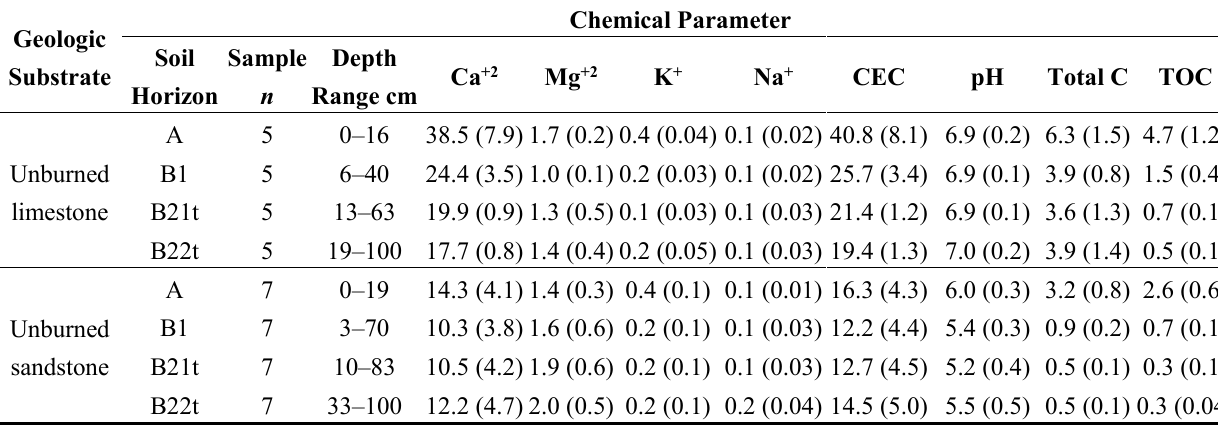
Table 9. Physical and chemical characterization of unburned limestone ( n = 5 sites) and sandstone ( n = 7 sites) soils on the Dude Wildfire study area 10 years postfire. Depths ranges are in centimeters for the sample size n, with soil chemistry parameter means by horizon. Values for Ca +2 , Mg +2 , K + , Na + , and total cation exchange capacity (CEC) are in cmol·kg − 1 with standard error of the mean (se); and values are in percent for Total Carbon and Total Organic Carbon with standard error of the mean (se). pH is